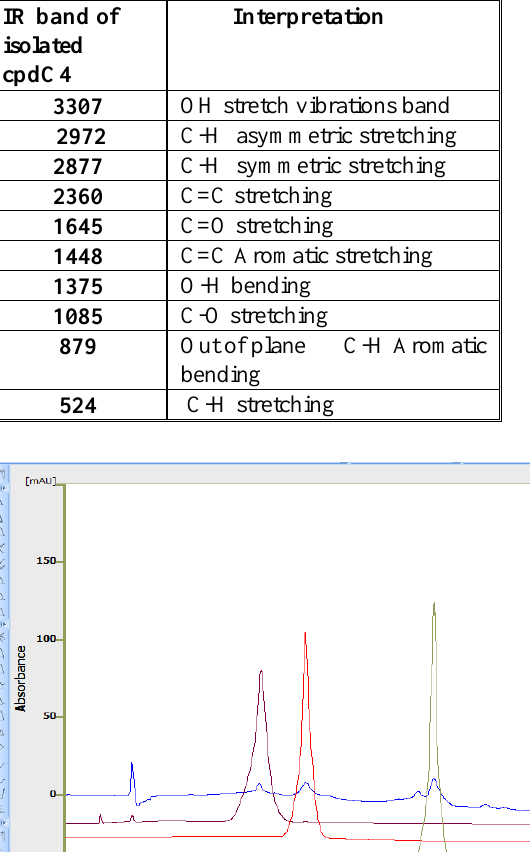
Table 4. interpretation of the IR bands for C4are shown below .